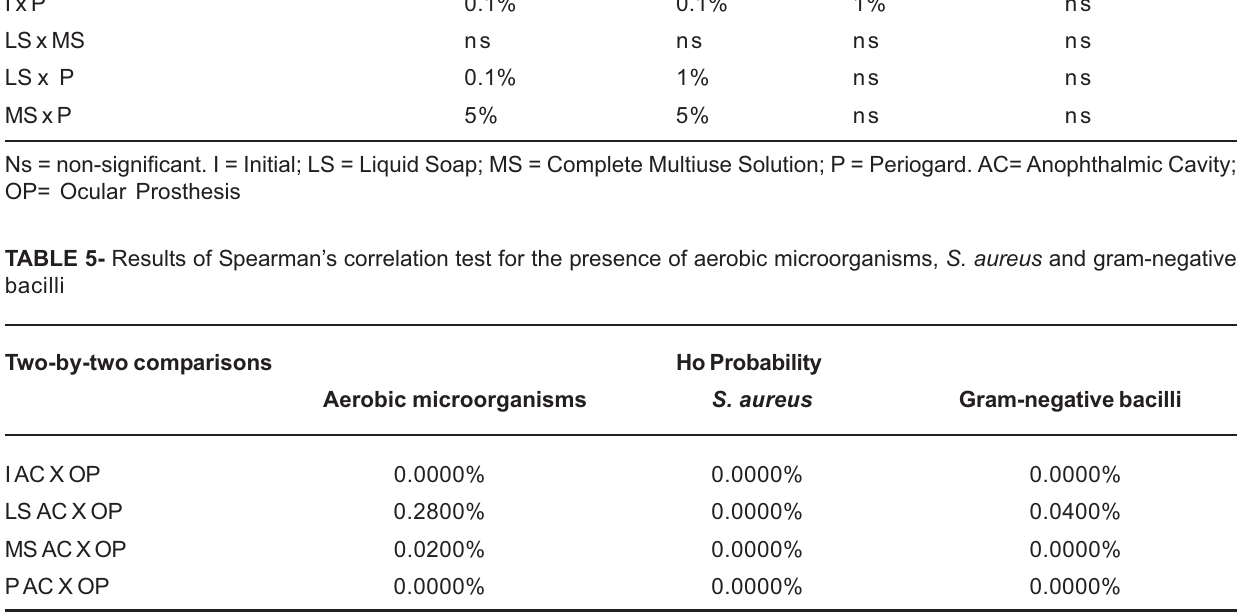
Ns = non-significant. I = Initial; LS = Liquid Soap; MS = Complete Multiuse Solution; P = Periogard. AC= Anophthalmic Cavity;